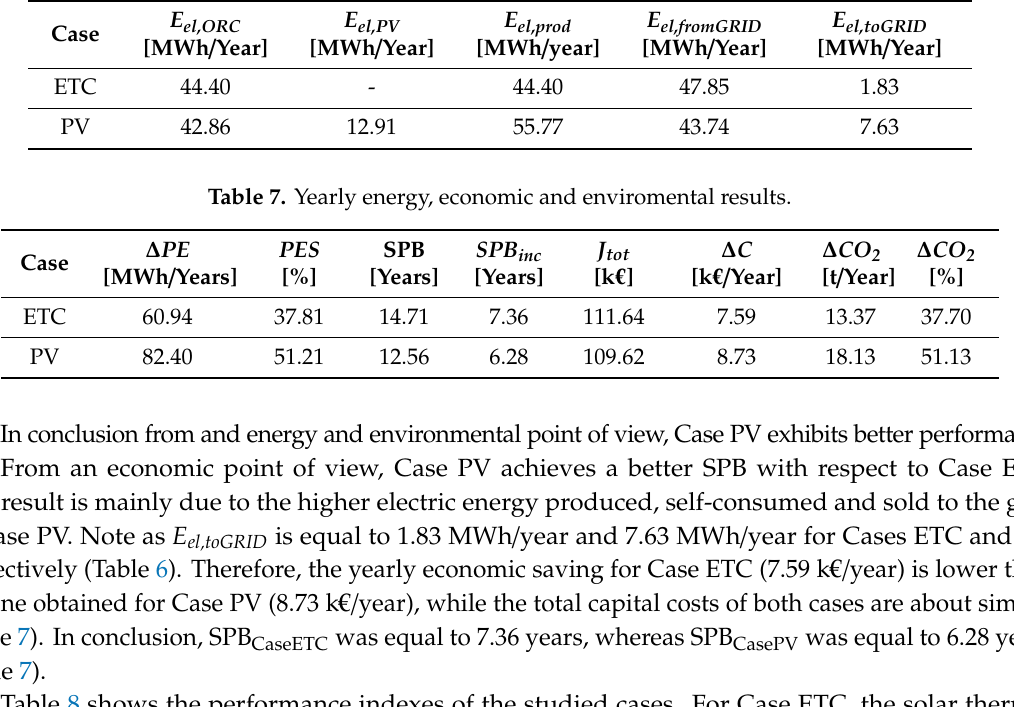
Table 6. Energy yearly results.